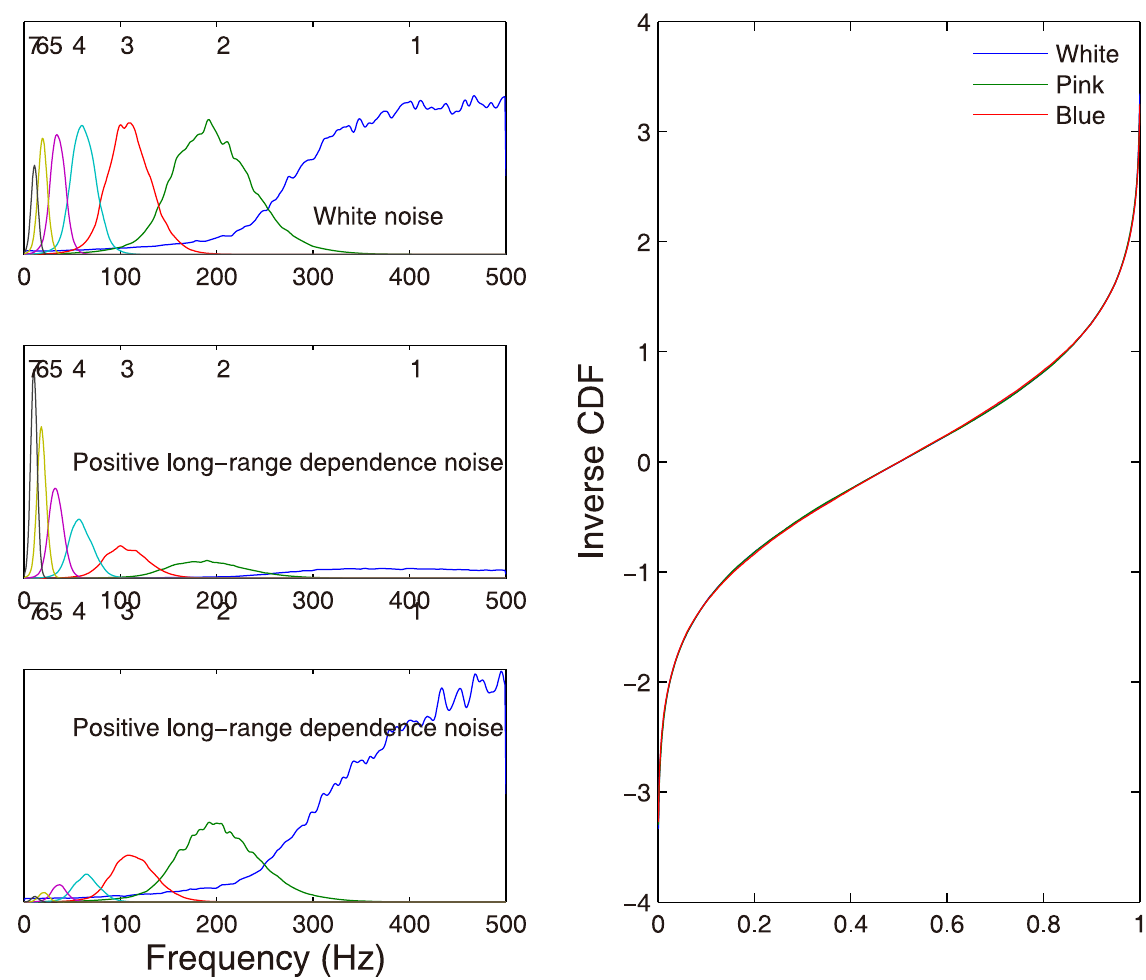
Figure 5. MEMD decomposition of the trivariate dada, consisting of three noise time series: the white noise (left top), the noise with positive long-range dependence (left middle) and the noise with negative long-range dependence (left bottom). The left panels show the power spectra of IMFs from the each noise (the sampling rate of 1000 Hz), in which the number denotes the order of IMF components. The right panel shows the inverse CDFs of IMF 3 from three different noise time series. Thanks to the rank-order statistics used in the estimation, there is an excellent match among three inverse CDFs, indicating that our approach is robust to the different types of noises.